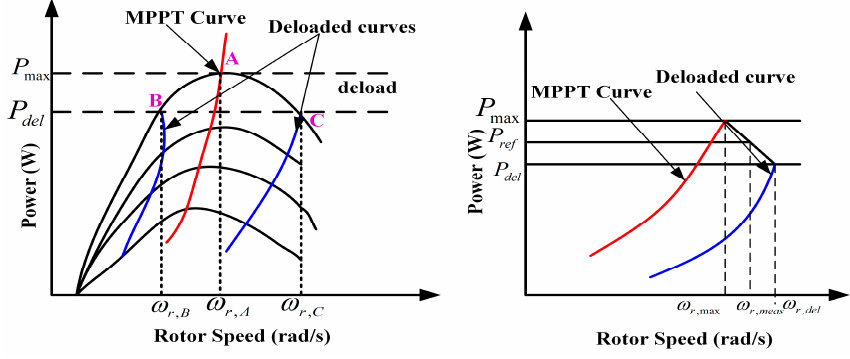
Figure 13. De-loaded operation for wind turbine.